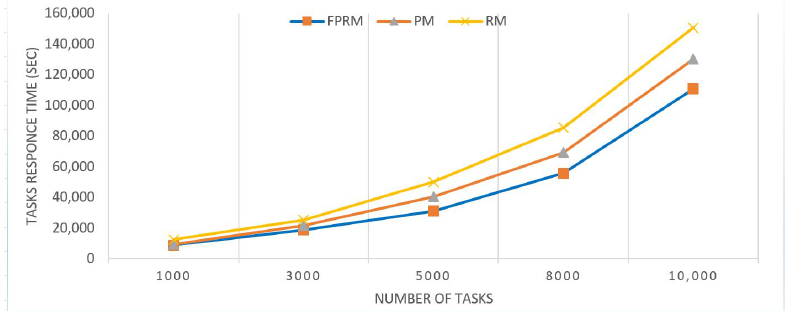
Figure 7. Number of tasks versus response time for , FPRM, PM and